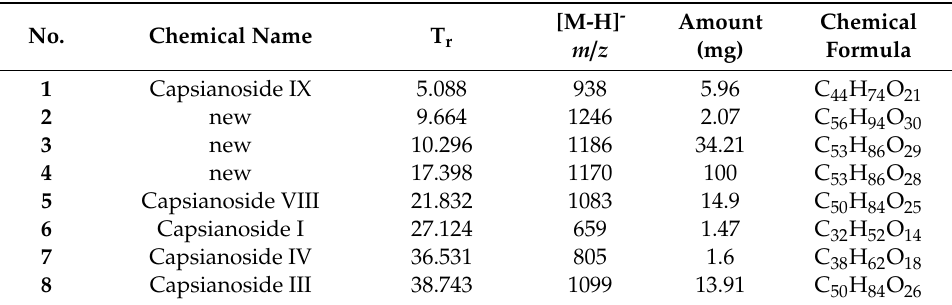
Table 2. Description of the Isolated